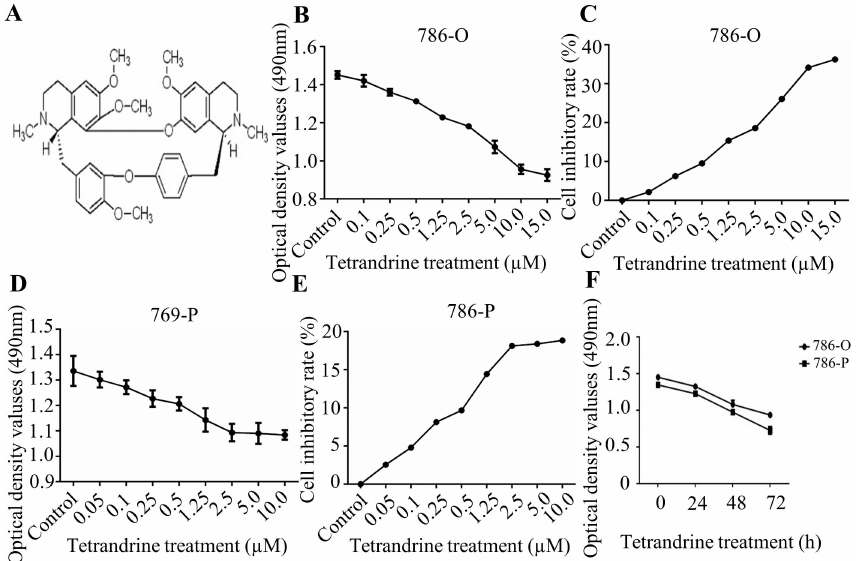
Fig 1. Tetrandrine(Tet) inhibitshuman RCC proliferation A. The chemicalstructure of Tet. The OD value and inhibitionrate of Tet on viabilityof RCC 786-O ( B, C ) and 769-P ( D, E ) cells. Cells under 90% cell density were treated with the vehiclecontrol or Tet at the indicatedconcentrations for 24h. The dynamicOD value was assayed at the concentration of 0.5 μ M ( F ). All the cell viabilitywas detected by modified MTT assay. The values were showed as mean ± S.E.The experiment was performed in